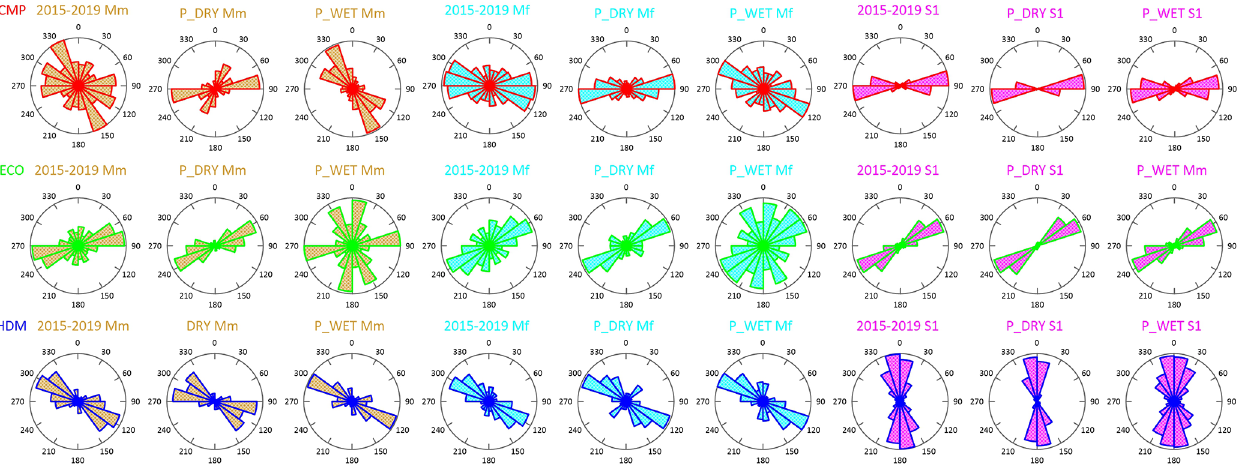
Figure 3. Rose diagrams of the azimuths of the tilt signals. Each row is relative to a tiltmeter (red = CMP, green = ECO, blue = HDM) and shows the azimuths retrieved in 2015–2019, P_DRY and P_WET time ranges for the Mm (ocre), Mf (cyan) and S1 (magenta) tidal constituents.